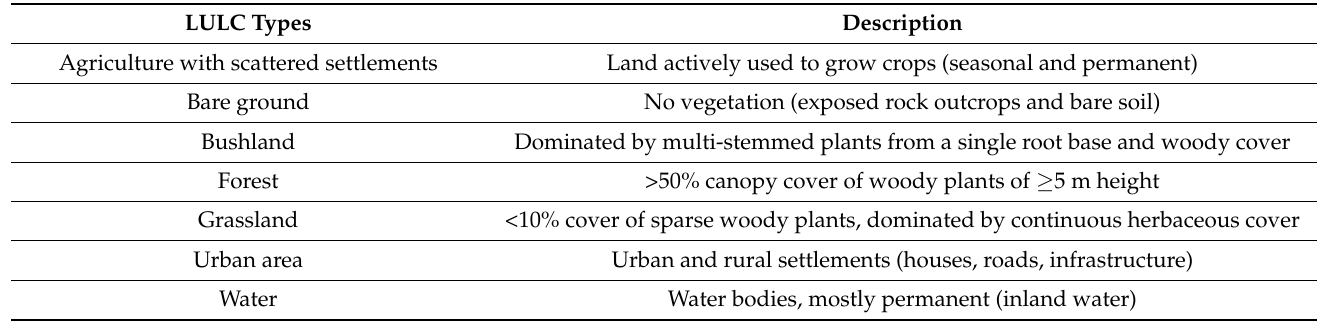
Table 1. Description of the land-use/land-cover (LULC) classes used in our analyses on land-cover change from 1998 to 2008 to 2018 in the Wami Mbiki–Saadani wildlife corridor, Tanzania, based on Reference [43], with some